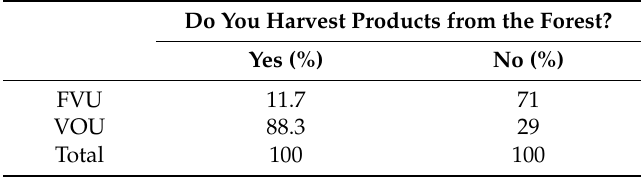
Table 4. The relationship between growing fruits and vegetables in a homegarden and forest